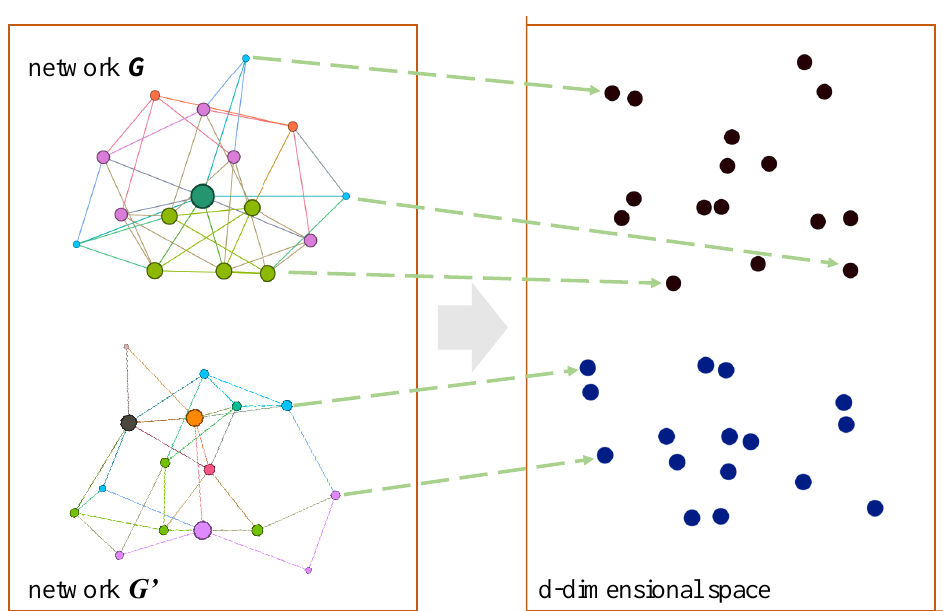
Figure 5. Process of graph embedding. Graph embedding methods can transfer the nodes of two networks to a low-dimensional continuous space while maintaining the essential structure and properties of the